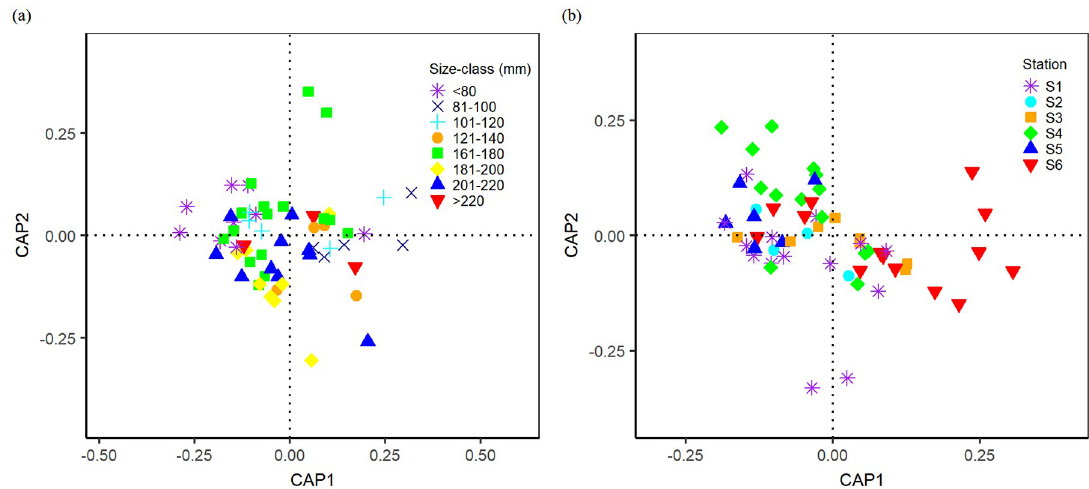
Fig 3. Canonical analysis of principal coordinates (CAP) based on size-class (a) and sampling station (b) of the fatty acid profiles among Uroteuthis duvaucelii , Uroteuthis edulis , Loliolus uyii and Uroteuthis chinensis in northern South China Sea. Station in (b) corresponds to the stars in Fig